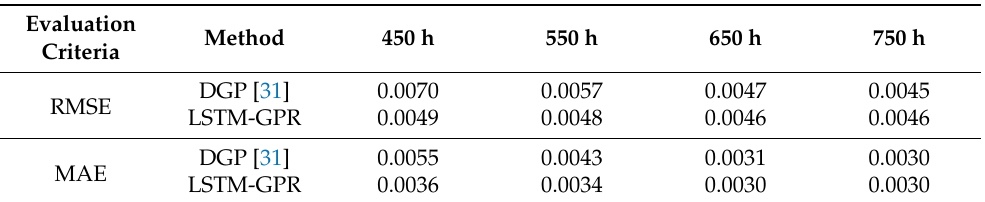
Table 3. Comparison of the prediction results of the proposed method with the DGP method at different training